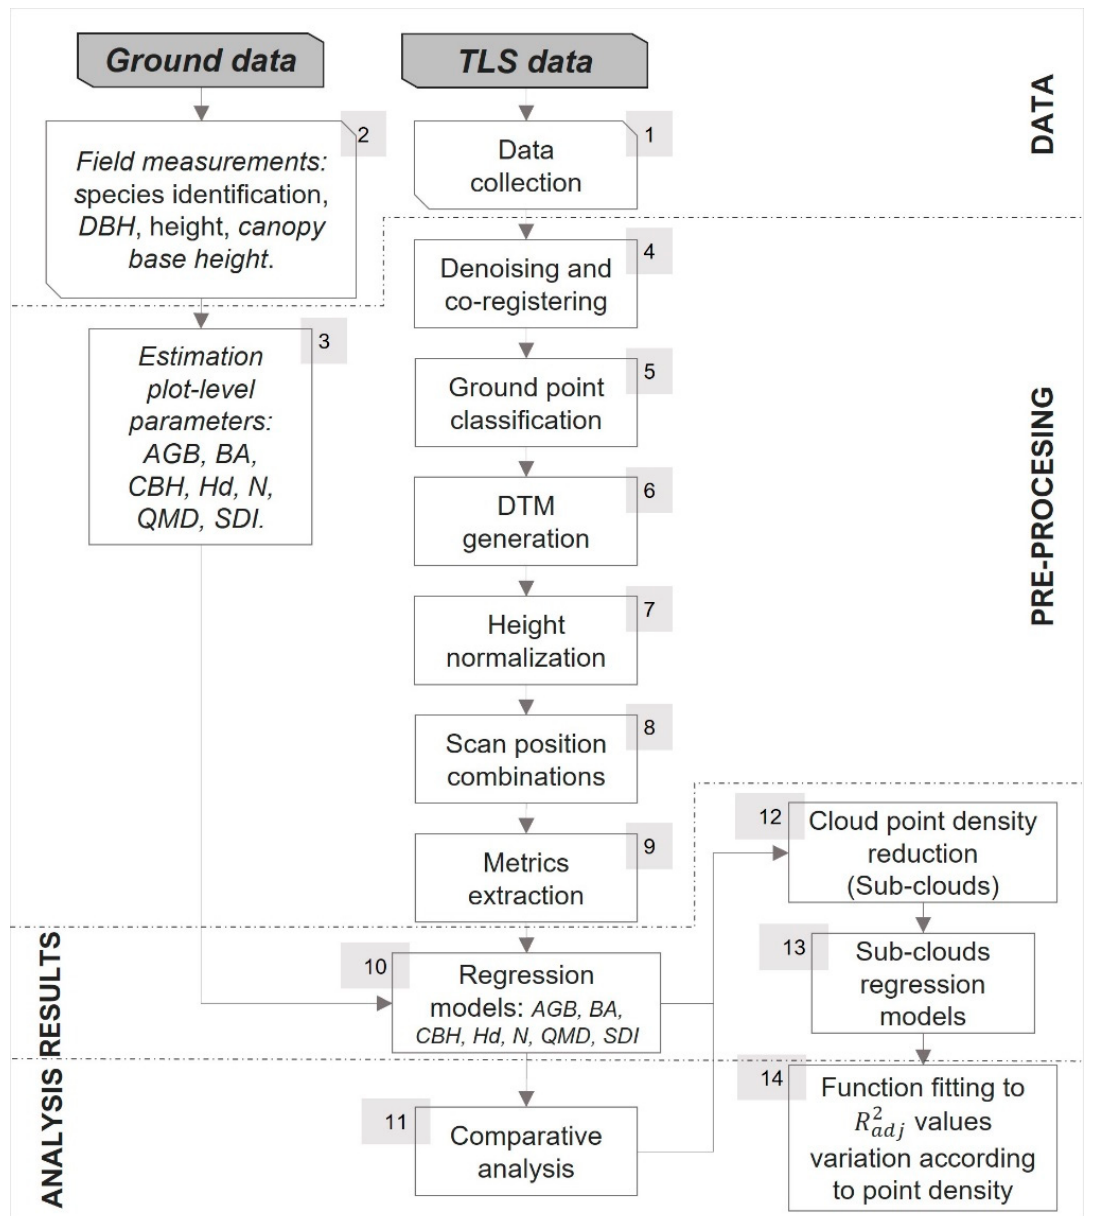
Figure 1. Overview of the methodological workflow. DBH , diameter at breast height; AGB , above- ground biomass per plot; BA , basal area per hectare; CBH , mean canopy base height of the 7 thickest trees on the plot; Hd , mean height of the 7 thickest trees on the plot; N , number of trees per plot; QMD , quadratic mean diameter; SDI , stand density index; and DTM, digital terrain model.